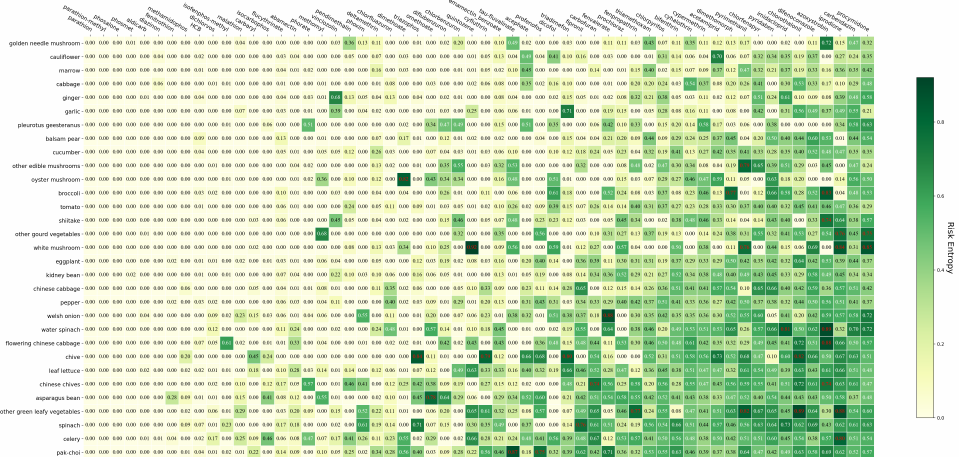
Figure 10. Heat map of the risk entropy of ‘Product + Indicator’, the row labels are the names of 31 agricultural products and the columns are labelled with 58 indicators of pesticide residue detection. Darker colours indicate higher values of the risk